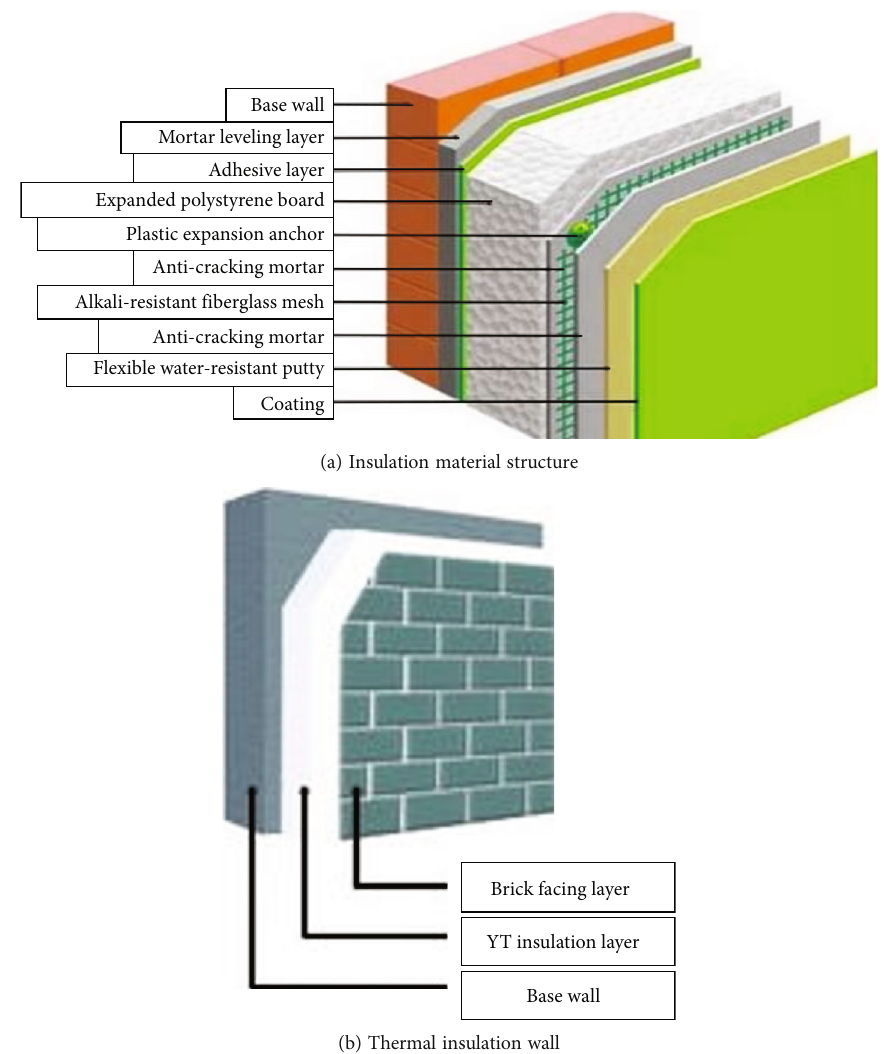
Figure 1: Selection of thermal insulation materials and design of thermal insulation walls in building energy-saving models in cold